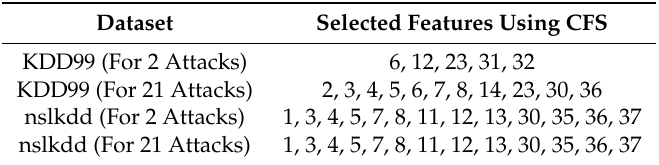
Table 8. Number of optimal features selected using